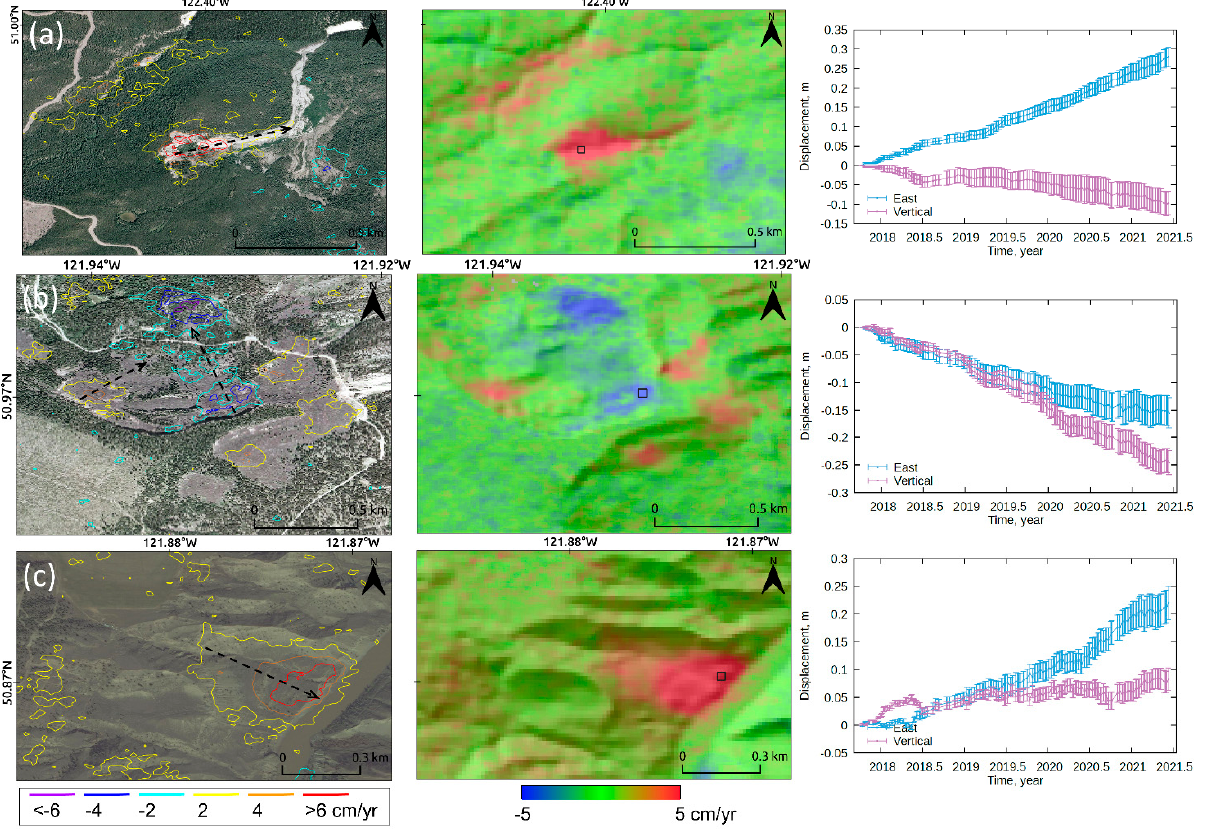
Figure 6. Close-ups of Sites 7–9 ( a – c , respectively) of Google Earth imagery ( left ) and the Sentinel-1 east–west movement map overlaid on the hillshade DEM (middle) with Sentinel-1 2D time-series plots ( right ; cumulative east–west (blue) and vertical (purple) movements extracted from 5-by-5 pixels marked in black squares in the middle panels). The color-coded contours and dashed black arrows in the left panels represent the east–west movement rates estimated by Sentinel-1 and the direction of earthflows, respectively. The error bars in the time-series plots represent the standard deviations of the 5–by–5 pixel measurements. Figure 7a represents the documented earthflow at Retaskit Creek [41].